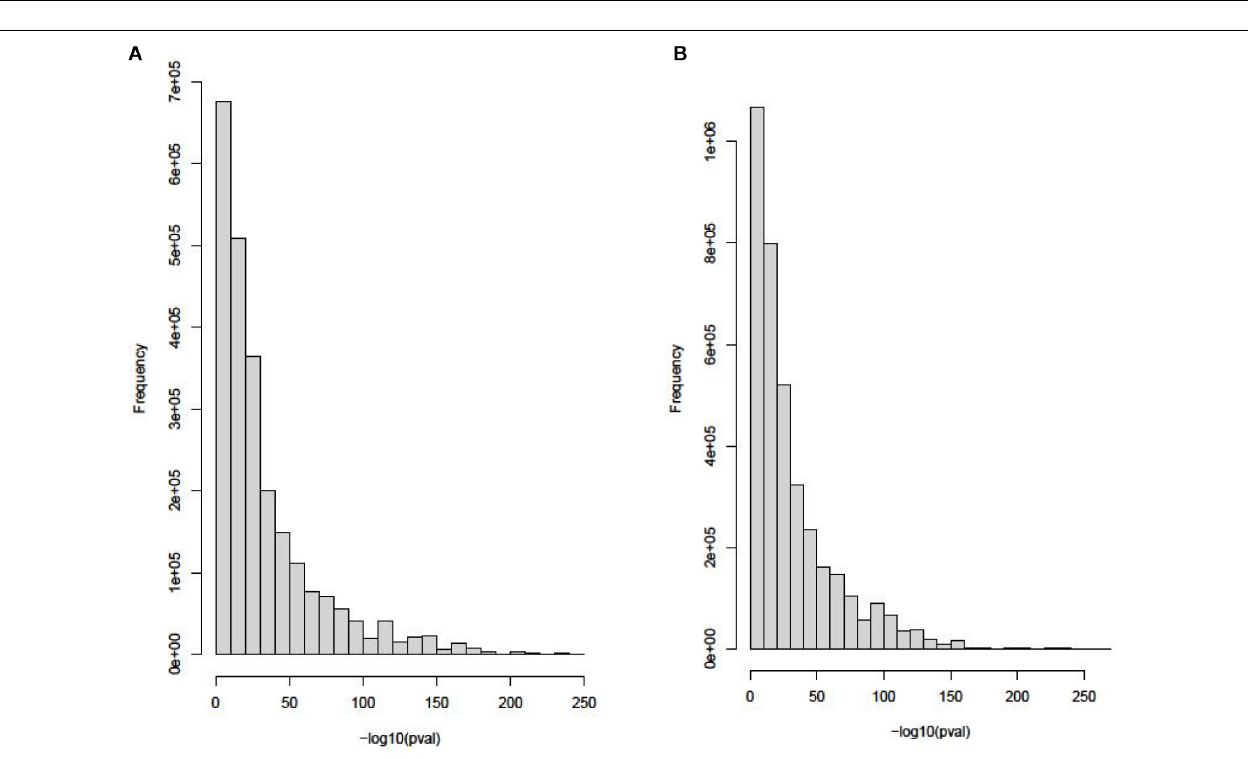
FIGURE 1 | The “Beta” and “ P -value” of all SNPs in the GWAS dataset. (A) Histogram of Beta in GWAS. (B) Histogram of P value in GWAS.